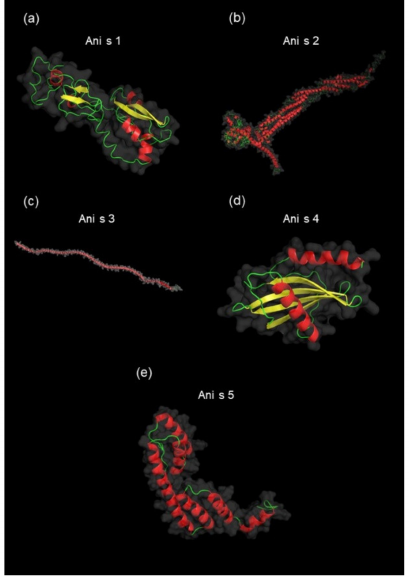
Figure 5. The native tertiary structures of identified allergens. Prediction of unknown 3D structures of allergens: Ani s 1 (77% of residues modeled at > 90% confidence, model dimensions in angstroms (Å): X:64.335 Y:49.060 Z:49.310) ( a ), Ani s 2 (99% of residues modeled at > 90% confidence, model dimensions in Å: X:160.179 Y:213.187 Z:160.224) ( b ), Ani s 3 (99% of residues modeled at > 90% confidence, model dimensions in Å: X:368.887 Y:109.731 Z:146.232) ( c ), and Ani s 4 (86% of residues modeled at > 90% confidence, model dimensions in Å: X:31.951 Y:46.659 Z:32.835) ( d ) were performed using the Phyre2 server. The allergen Ani 5 structure was visualized based on the structure from the Protein Data Bank PDB ID: 2MAR ( e ). PyMOL software was used to visualize all structures. Colors of the allergen models are according to secondary structure: helices highlighted in red, sheets in yellow, and loops in